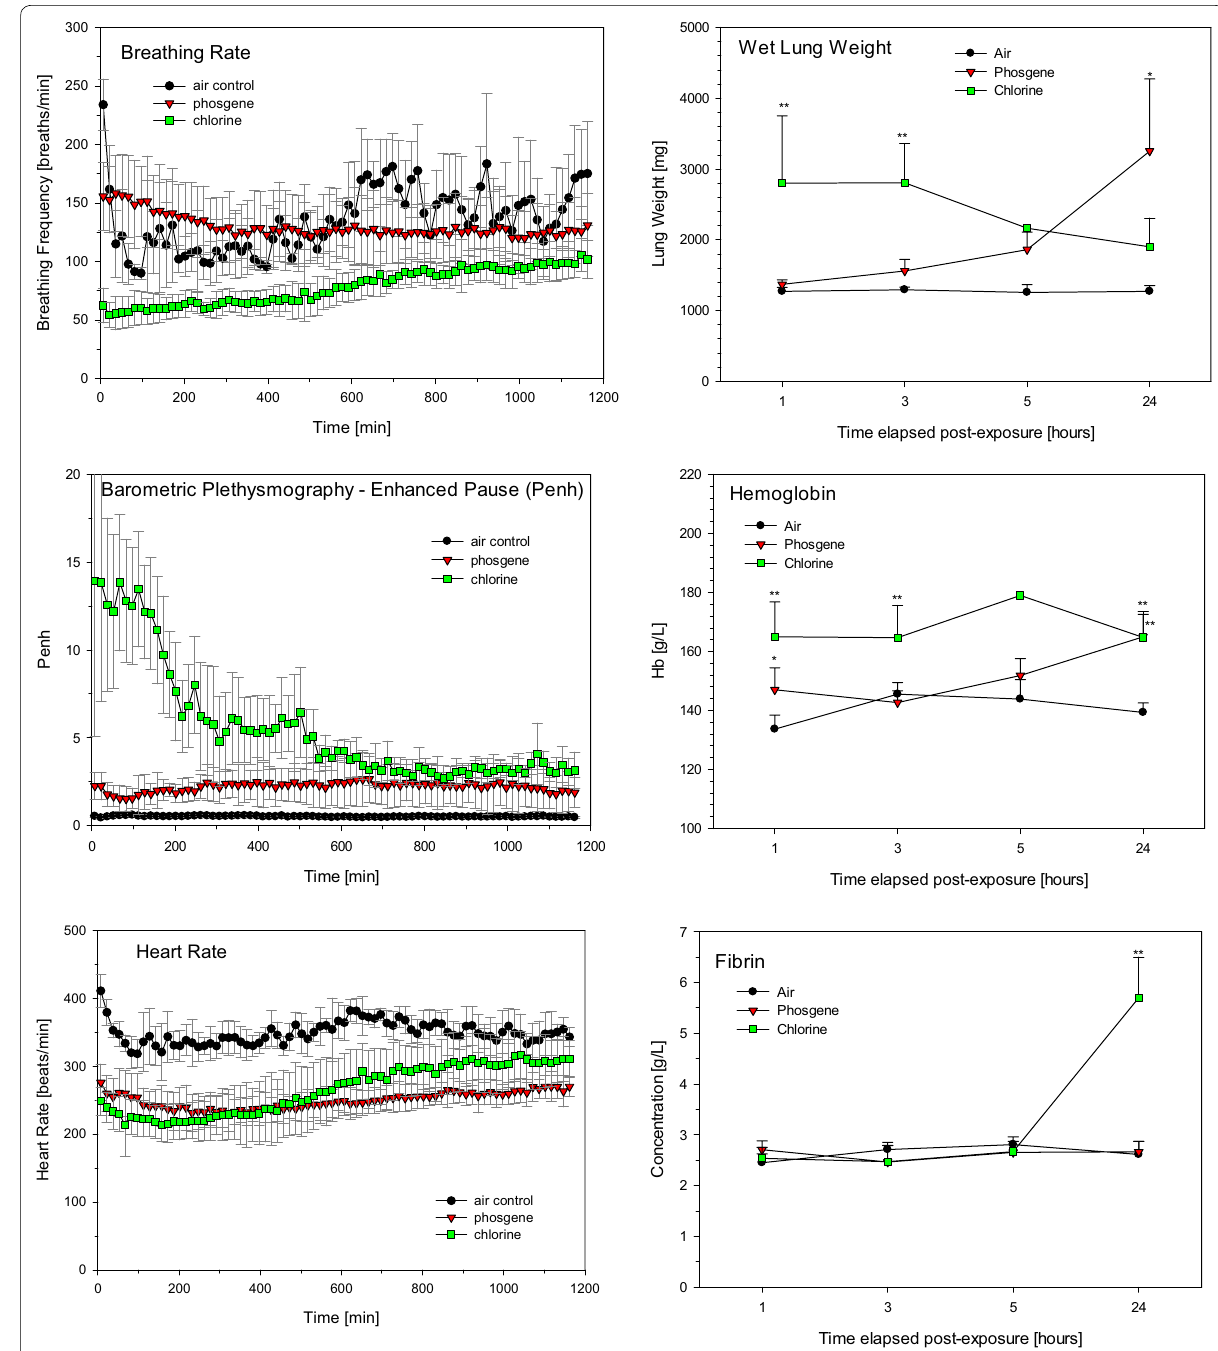
Fig. 8 Comparison of three groups of rats sequentially nose-only exposed for 30 min to air, m 3 (413 ppm) chlorine gas. Cardiopulmonary endpoints were determined as detailed in the caption of Fig. 2. Lung weights, hemoglobin, and fibrin were determined 1, 3, 5, and 24 h post-phosgene exposure (for details see [47]). Data points represent means unscheduled deaths in the chlorine group the actually examined number of rats were 3, 1, and 4 at the 3, 5, and 24 h sacrifices, respectively. Aster- isks (*) denote significant differences between the phosgene and chlorine groups (*P < 0.05, **P <